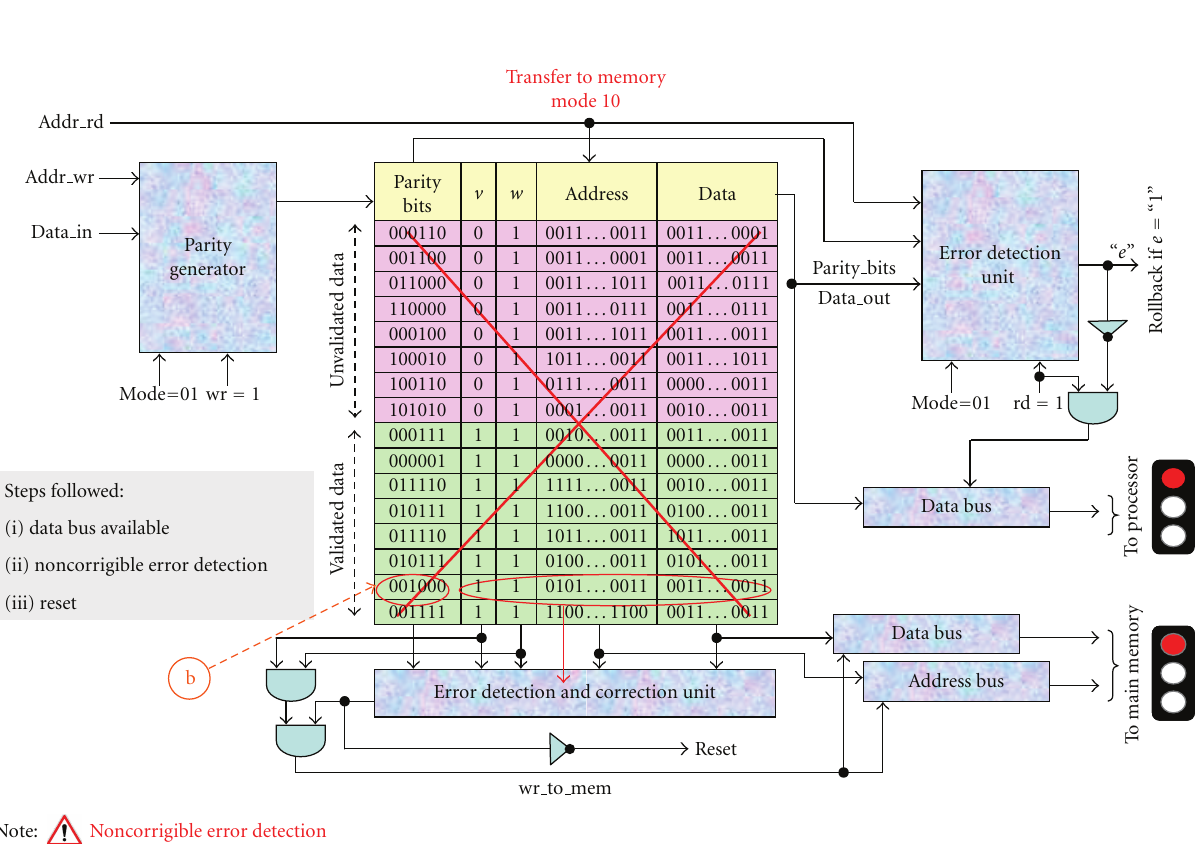
Figure 13: Mode 10 of SCHJ operation.